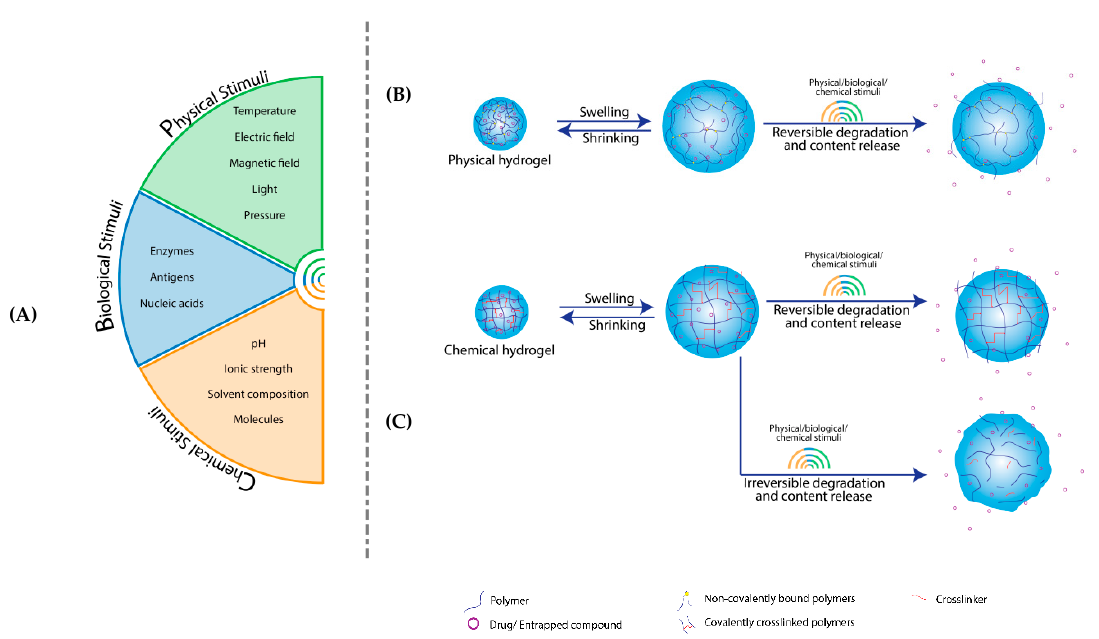
Figure 2. Stimuli sensitive hydrogels structural changes. ( A ) Stimuli categories: physical, biological and chemical. ( B ) Physical hydrogels are non-covalently crosslinked and in an aqueous environment, they swell. Under various stimuli presence, they undergo reversible structure modifications and release the compound. ( C ) Chemical hydrogels describes covalently crosslinked formulation that swells in aqueous conditions and then suffers reversible or irreversible alterations depending on stimuli presence and crosslinking strength, which influence their discharge.